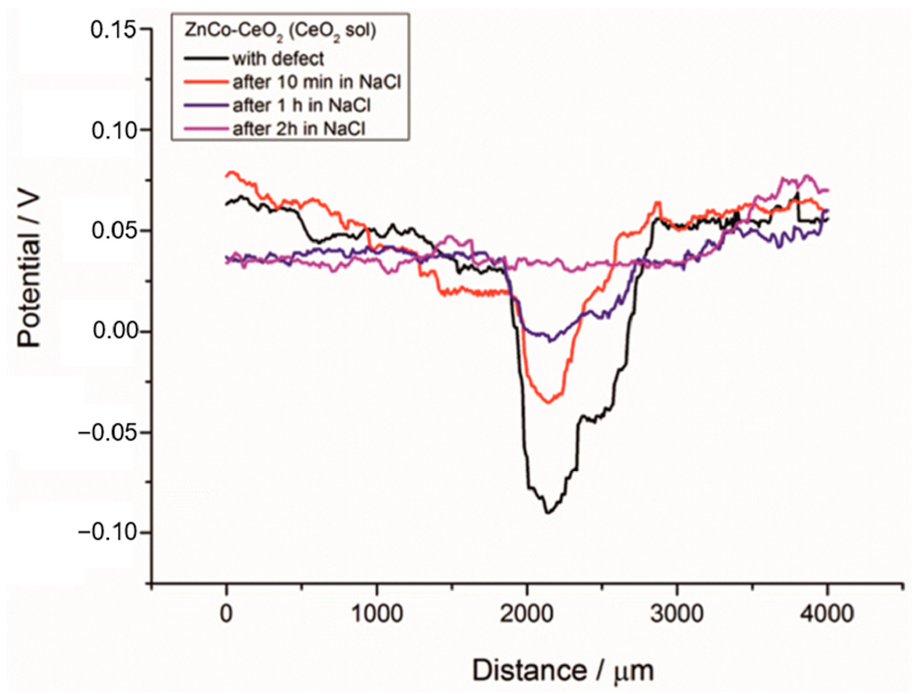
Figure 19. SKP line scan of the Zn-Co-CeO 2 (CeO 2 sol) composite coatings with artificial defect before and after immersion in 3 wt.% sodium chloride.